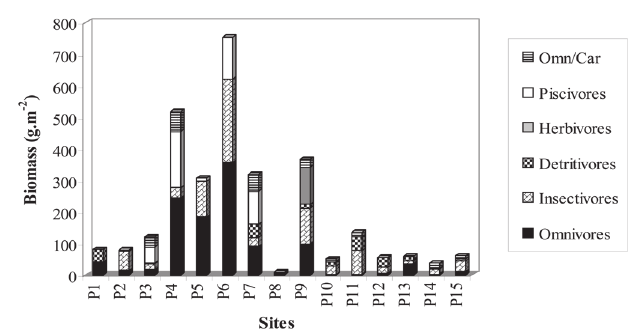
Fig. 3. Biomass (g.m -2 ) of the different trophic groups of fish at each collecting site in Serra do Japi (SP) streams.